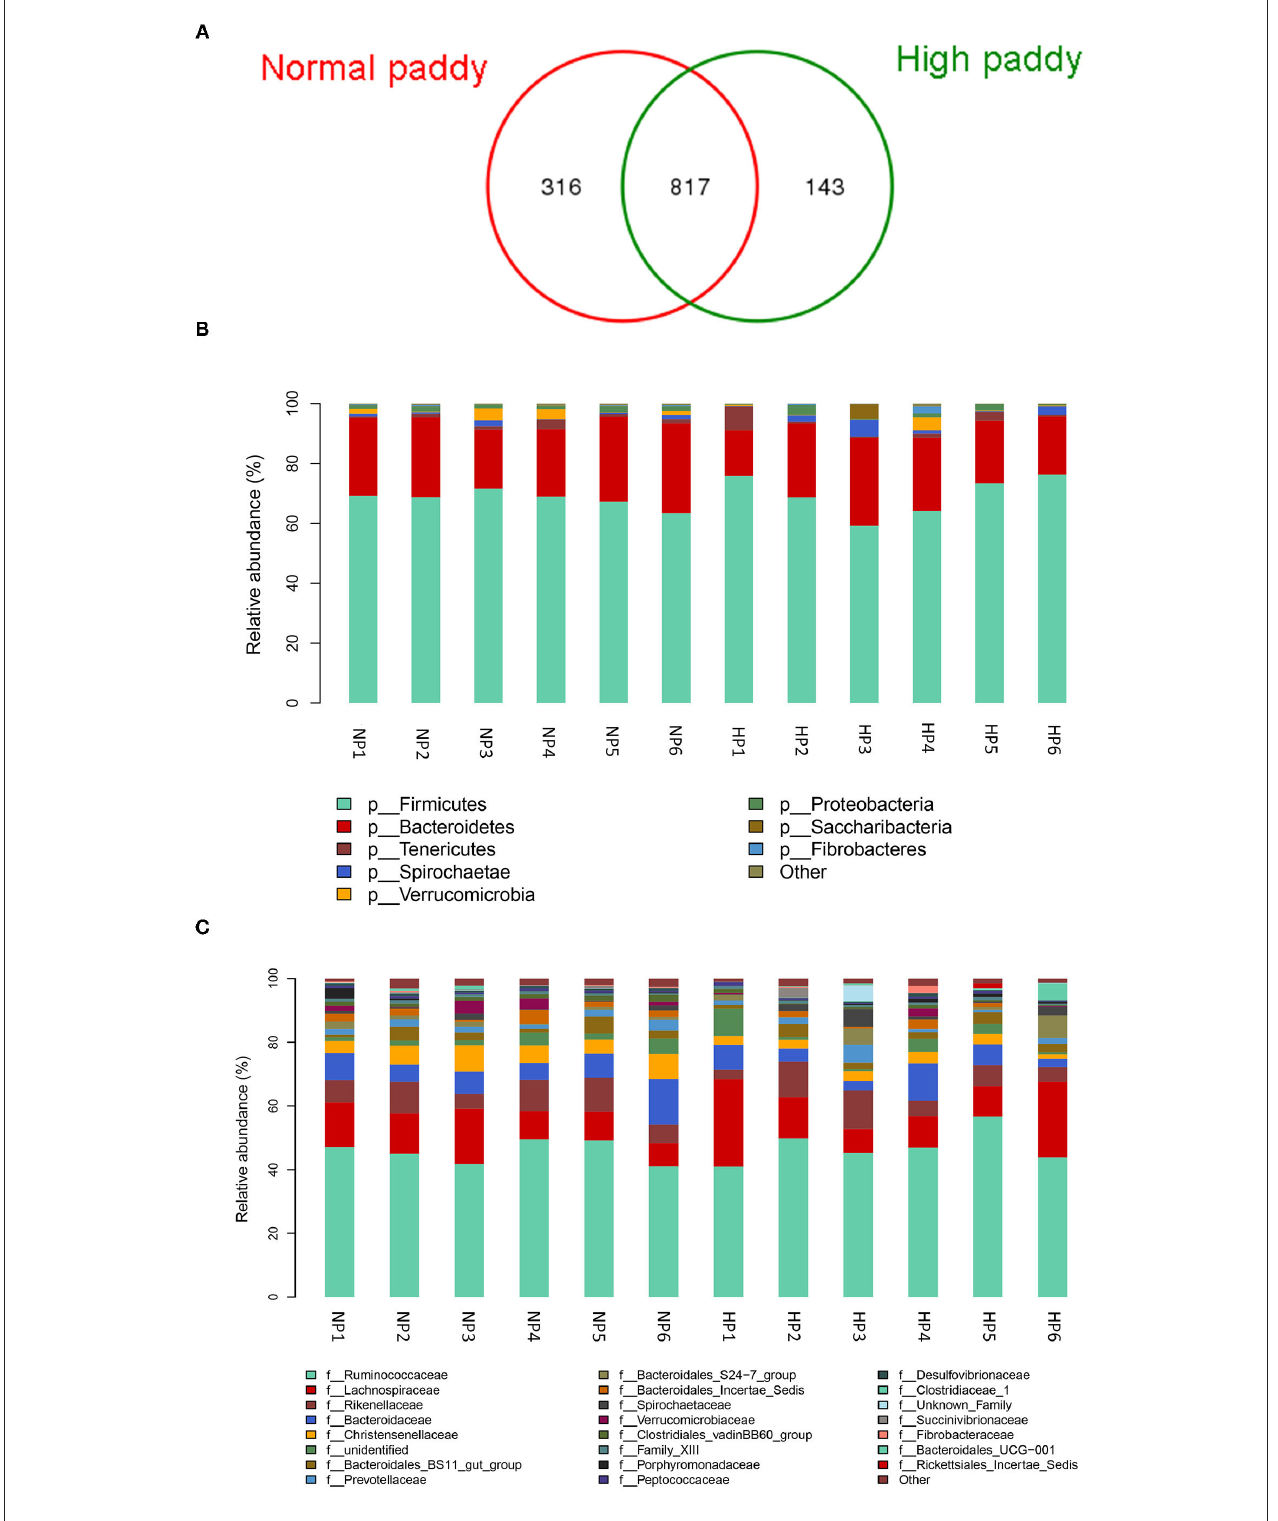
FIGURE 4 | Effects of HP diet on hindgut microbiota of goats. (A) Venn diagram of the OTUs in different treatments. (B) Distribution of cecal microbiota at the phylum level in goats. (C) Distribution of cecal microbiota at the family level in goats (NP1–NP6 and HP1–HP6 are cecal samples of goats fed with NP and HP diets,